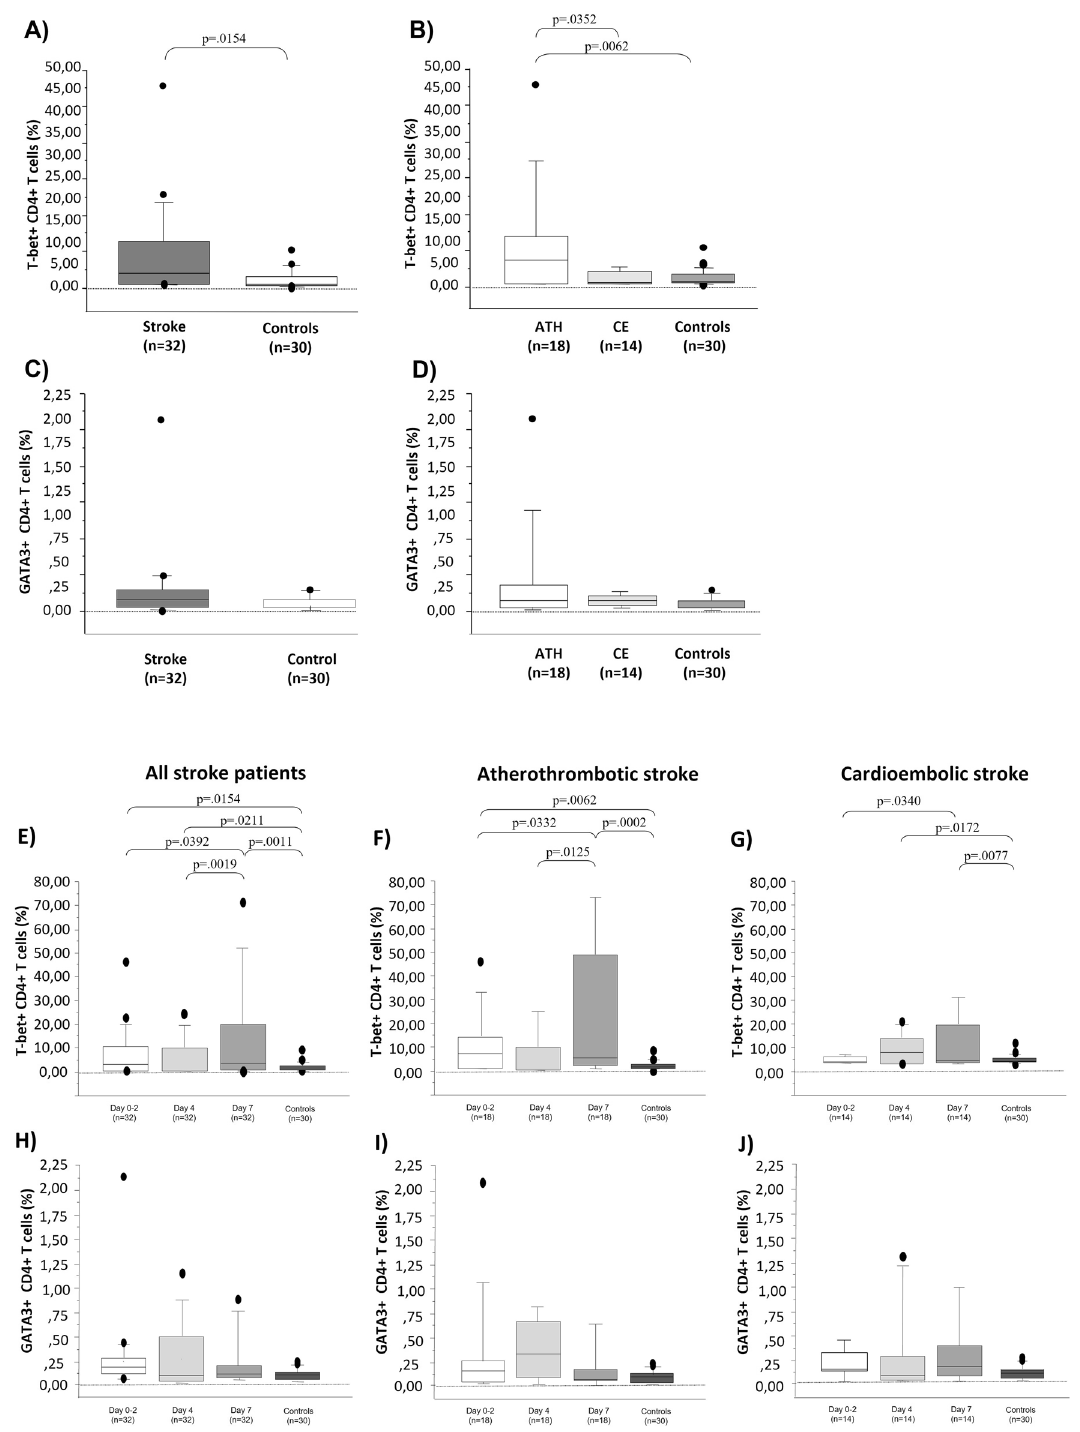
Figure 1. Percentage of circulating CD4 + T-bet + ( A , B , E – G ) and CD4 + GATA3 + T cells ( C , D , H – L ) in acute stroke patients and controls. Box plots express the first (Q1) and third (Q3) quartiles within a given dataset by the upper and lower horizontal lines in a rectangular box, in which there is a horizontal line showing the median. The whiskers extend upwards and downwards to the highest or lowest observation within the upper (Q3 + 1.5 × interquartile range) and lower (Q1 − 1.5 × interquartile range) limits. Data points that are outside this interval are represented as points on the graph and considered potential outliers. p values indicate statistical significances (< 0.05) between the different